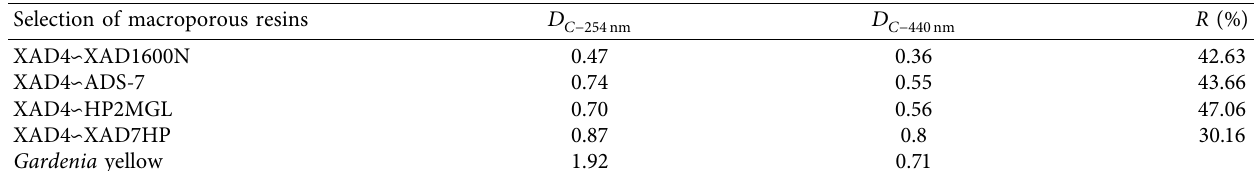
C − 440nm ) and recovery ratio ( R ) of crocin-I on four combination of in-series macroporous